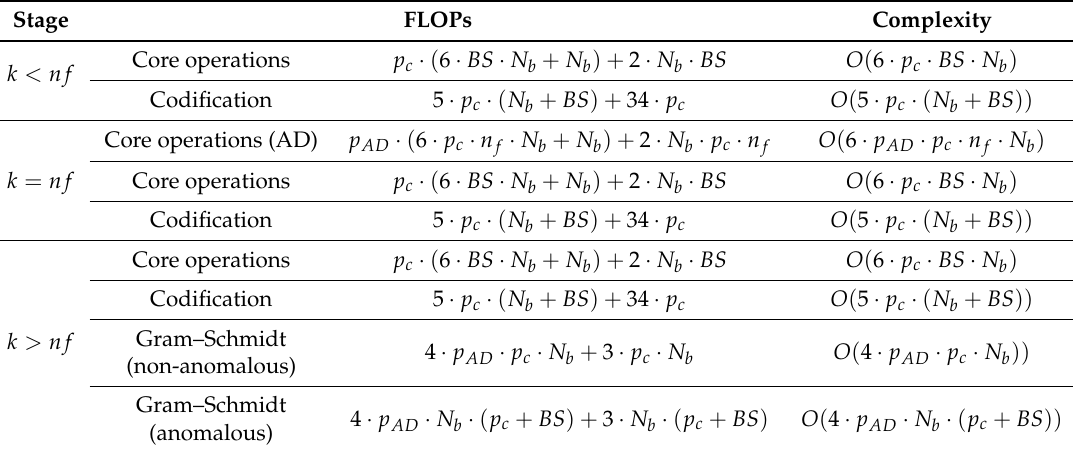
Table 1. Number of FLOPs and computational complexity of each stage of the proposed methodology.